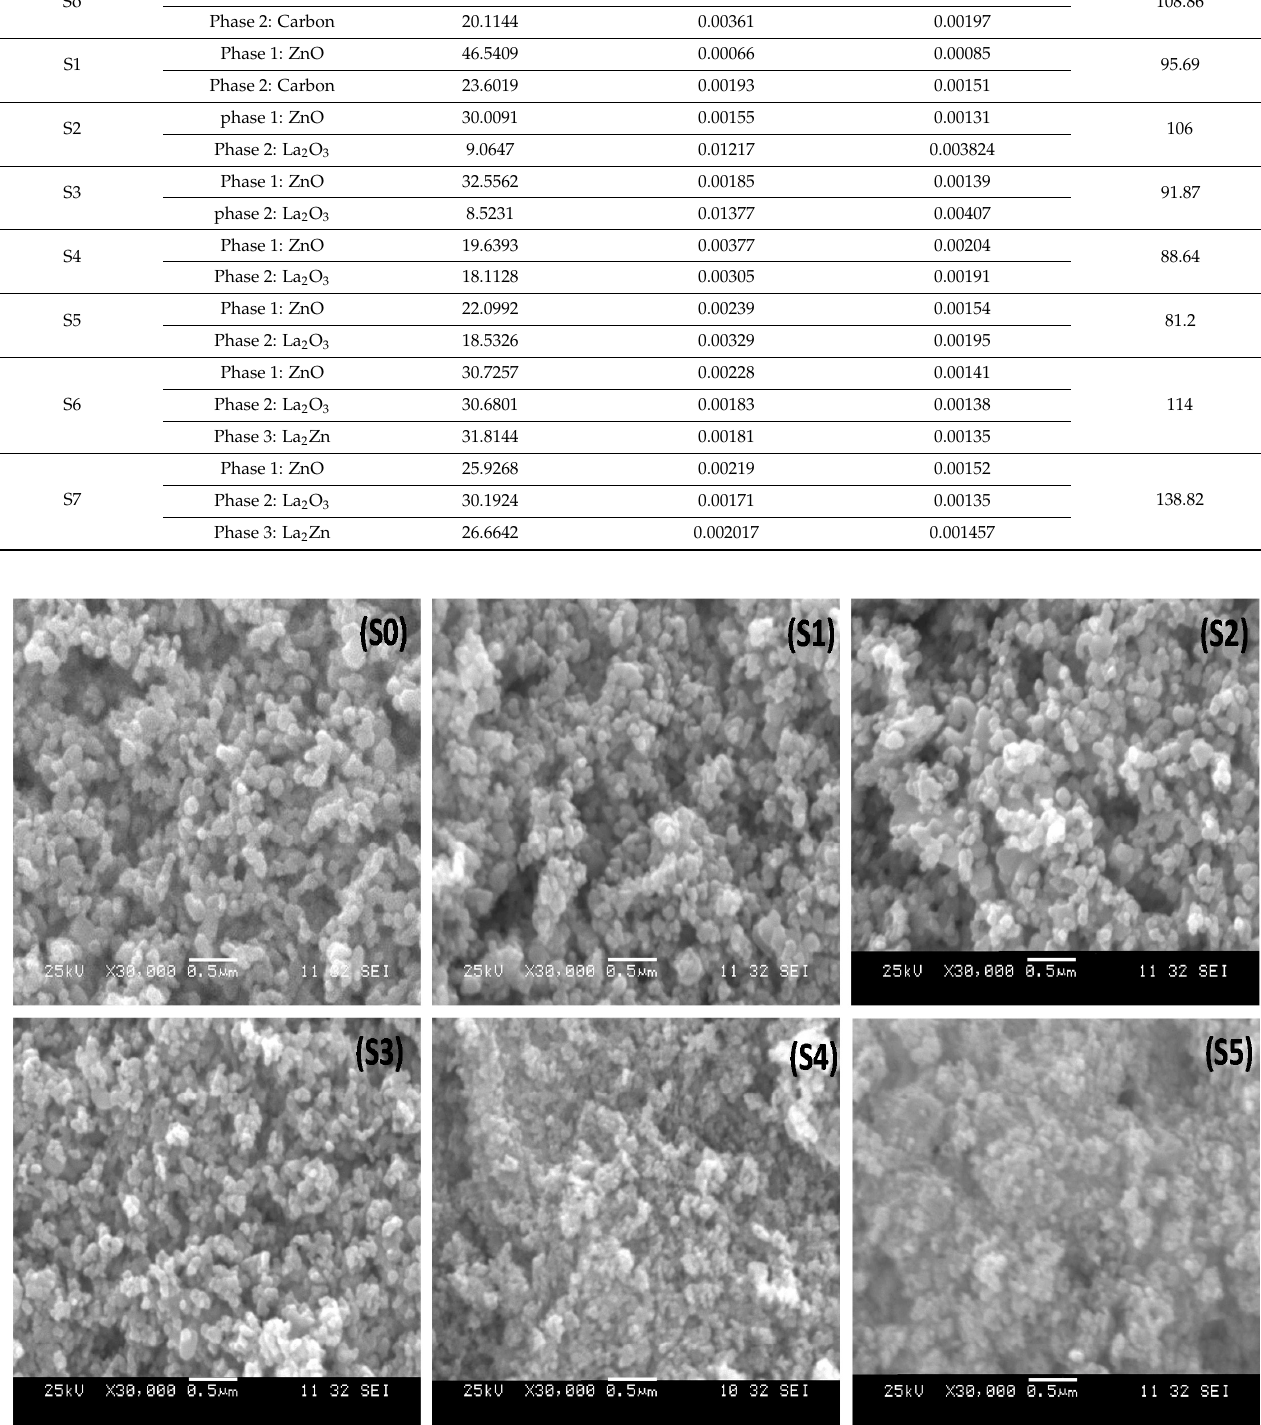
Figure 2. SEM pictures of the synthesized La 2 O 3 –ZnO nanocomposites at various concentrations. Table 2. A comparison of the XRD-derived crystallite size, dislocation density, and lattice strain. Samples